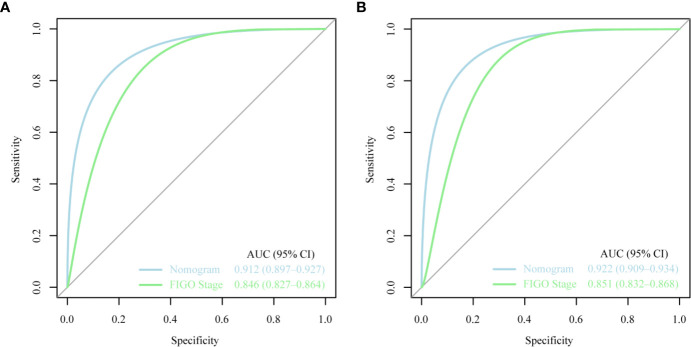
The receiver operating characteristic (ROC) curve for nomogram. (A) The total early death; (B) The cancer-specific early death. AUC, area under the curve; ROC, receiver operating characteristic.